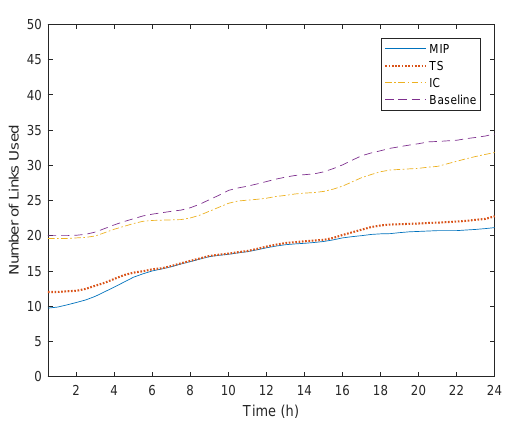
Figure 11. Total number of links used.